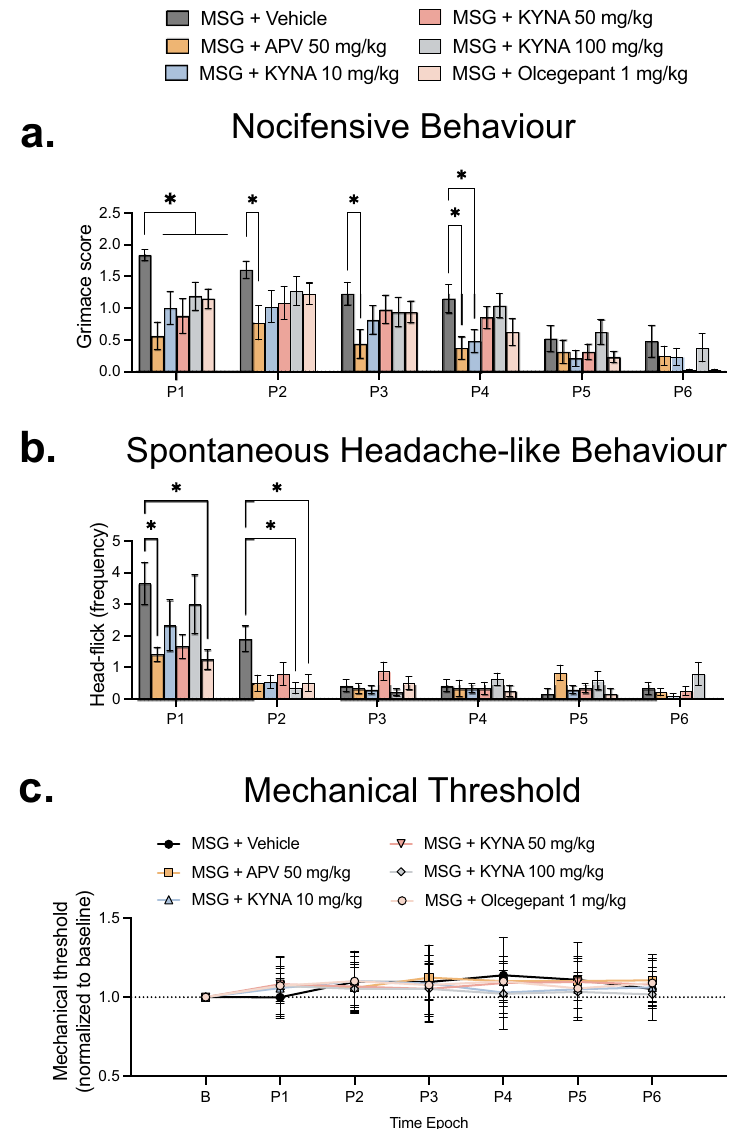
Figure 1. APV, KYNA and Olcegepant attenuate MSG-induced nocifensive and headache-like behaviours. Comparison of the effect of MSG (1000 mg/kg; i.p.) alone compared with APV (50 mg/kg; i.p.), KYNA (10, 50, 100 mg/kg; i.p.) and olcegepant (1 mg/kg; i.p.) in combination with MSG (1000 mg/kg; i.p.) on ( a ) Grimace scores, ( b ) Head-flick frequency and ( c ) Temporalis muscle MT. Note: APV significantly attenuated MSG-induced nocifensive behaviour over the first 40 min, while also significantly decreasing MSG-induced head-flick frequency during the first 10 min compared to MSG alone. KYNA at all doses decreased MSG- induced nocifensive behaviour during the first 10 min, and the highest dose (100 mg/kg) also reduced head- flick frequency from 10 to 20 min compared to MSG alone. Olcegepant reduced MSG-induced nocifensive behaviour for the first 10 min, and head-flick frequency for the first 20 min compared to MSG alone. There was no significant effect of any of the treatments on MT. Data are mean ± SEM (n = 12) * p < 0.05, repeated measures two-way ANOVA and Dunnett’s test. Time Epoch = P1 (0–10 min), P2 (10–20 min), P3 (20–30 min), P4 (30–40 min), P5 (40–50 min) and P6 (50–60 min) post